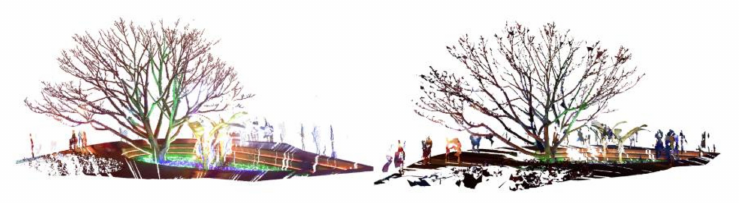
Figure 4. Original scan: 1.38 million points vs. Augment ® AR mesh: 0.28 million points, 0.50 mil- lion